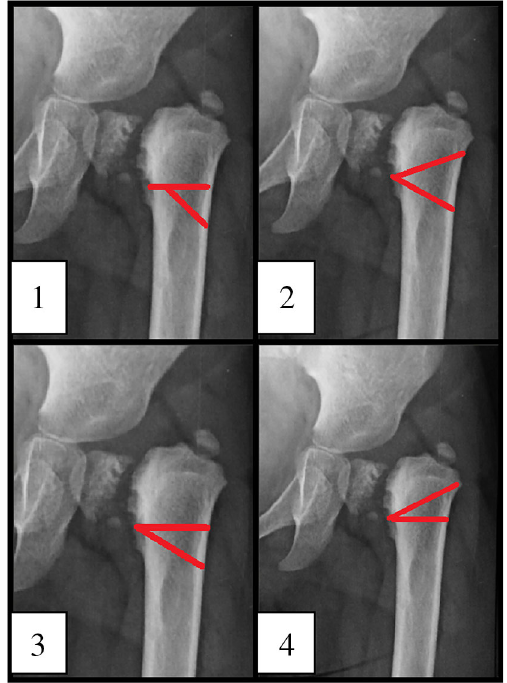
Fig. 10 Diagrammatic presentation of various possible shapes of intertrochanteric osteotomy. 1 Classical Y-shaped osteotomy. 2 V-shaped osteotomy with both arms of the osteotomy oblique. 3 , 4 V-shaped osteotomy with a horizontal proximal or distal arm and the other arm